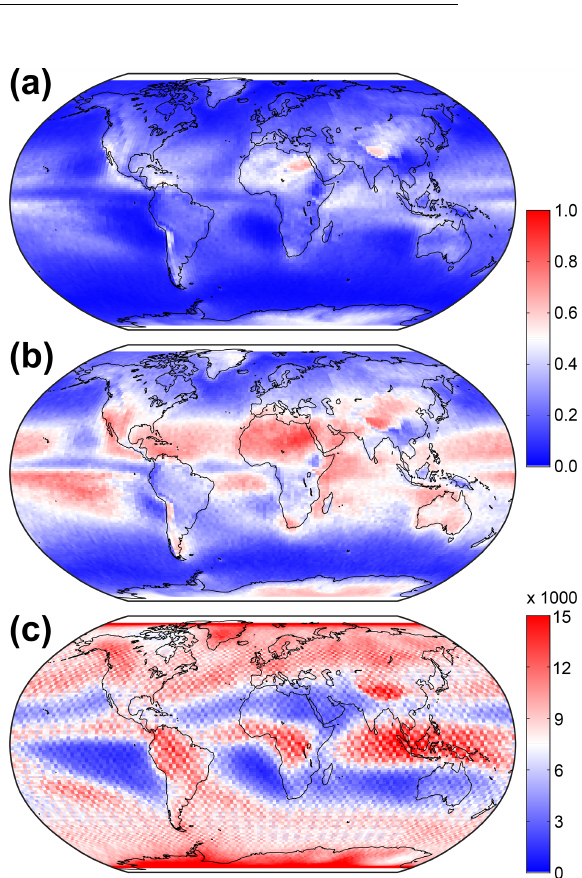
Figure 1. Global distribution of (a) the ratio of CALIPSO profiles that contain cirrus clouds in the absence of opaque low- and mid- level clouds versus all cloudy profiles, (b) the ratio of CALIPSO profiles that contain cirrus clouds in the absence of opaque low- and mid-level clouds versus all cirrus-containing cloudy profiles, and (c) the number of cirrus-containing cloudy profiles per grid